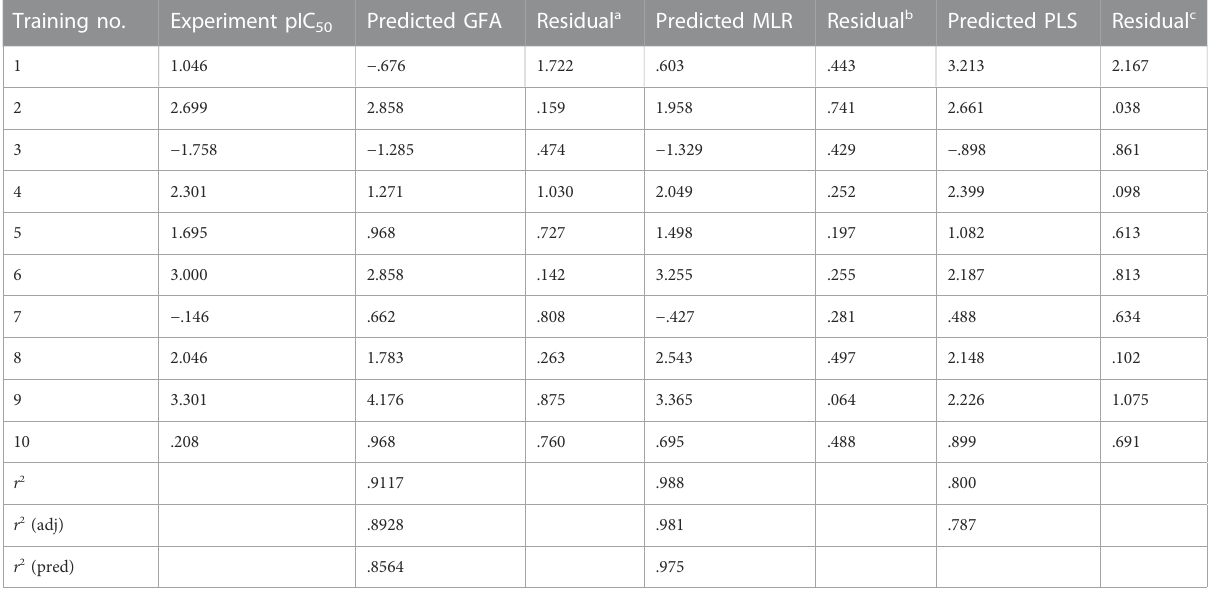
TABLE 1 Based on the 2D-QSAR test set compound experimental and predicted activity pIC50 ( μ M). Training no. Predicted GFA Residual a Predicted MLR Residual b Predicted PLS Residual